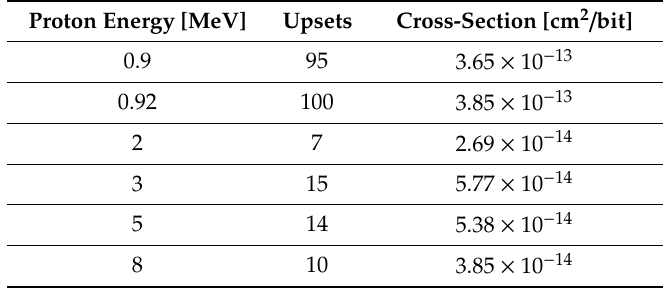
Table 5. Simulation results of single event upset (SEU)